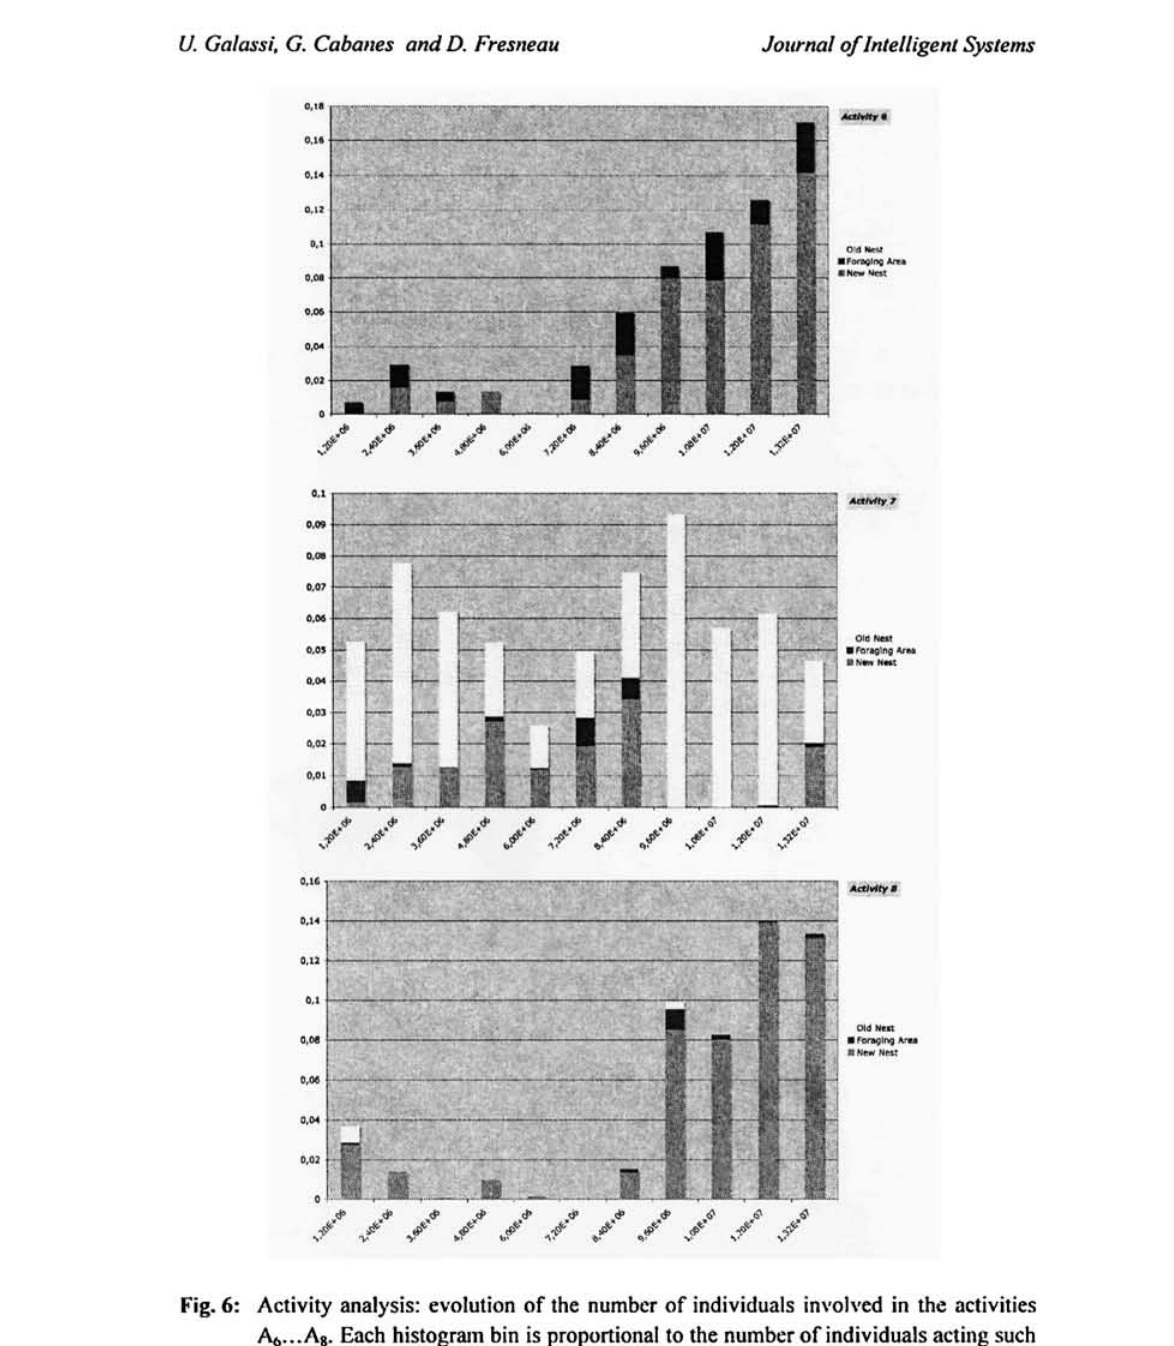
Fig. 6: Activity analysis: evolution of the number of individuals involved in the activities Ao-.-Ag. Each histogram bin is proportional to the number of individuals acting such activity in a 20 minutes window. The bins are subdivided according to the number of individuals that are present in the old nest, the foraging area or the new